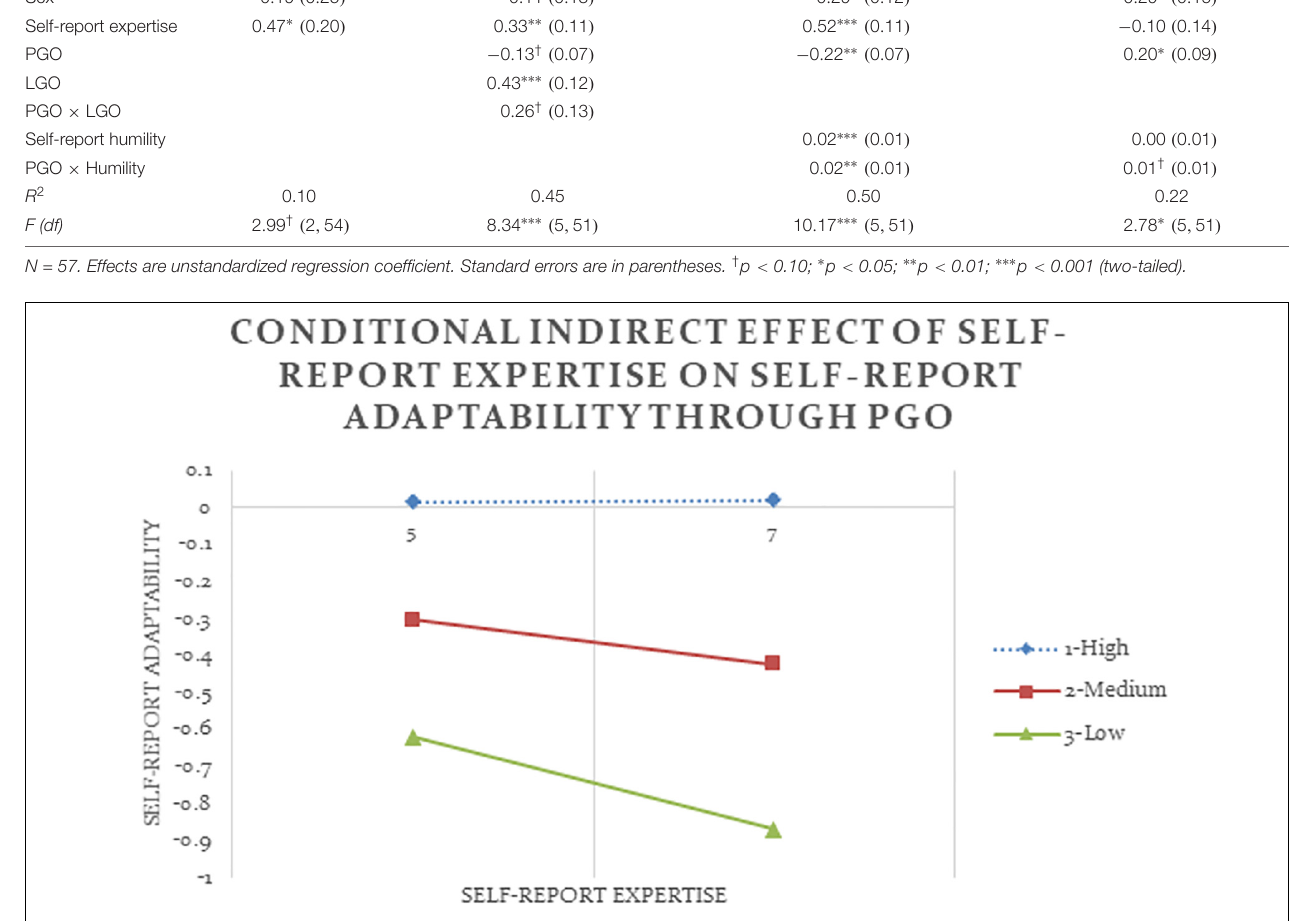
FIGURE 2 | Conditional indirect effect of self-report expertise on self-report adaptability through PGO is significant at low and medium values of the moderator LGO with 90% confidence (Analysis